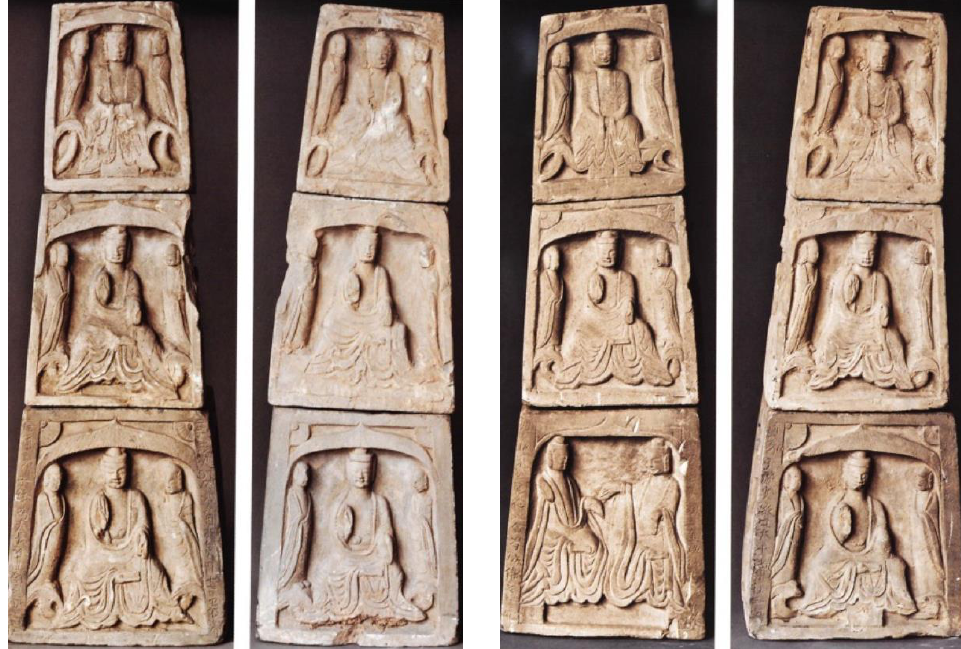
Figure 6. Pagoda from Xiejiamiao, Huating, Gansu Province. 558, Northern Zhou. Stone. H. 78.6 cm, W. (bottom) 26 cm. Huating Museum. Reprinted with permission from ref. [Gansu guta yanjiu]. 2014, Gansu Sheng Wenwu Ju, pp. 55–56.